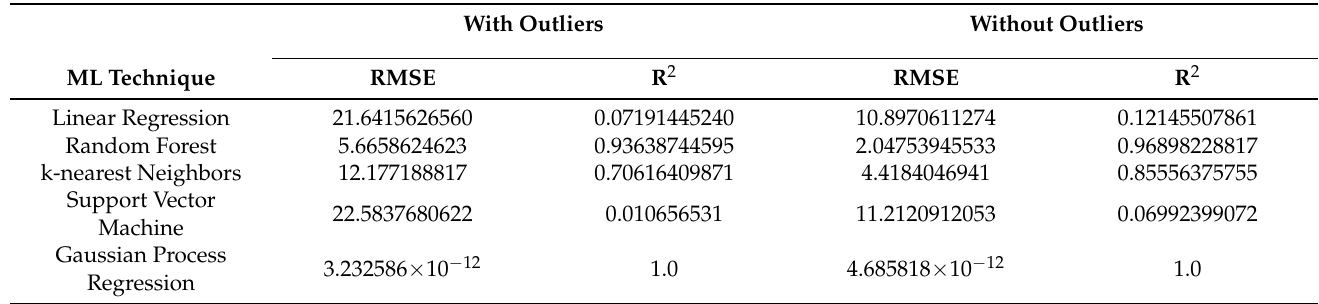
Table 14. PM 10 results for the suspended particulate matter measuring device.